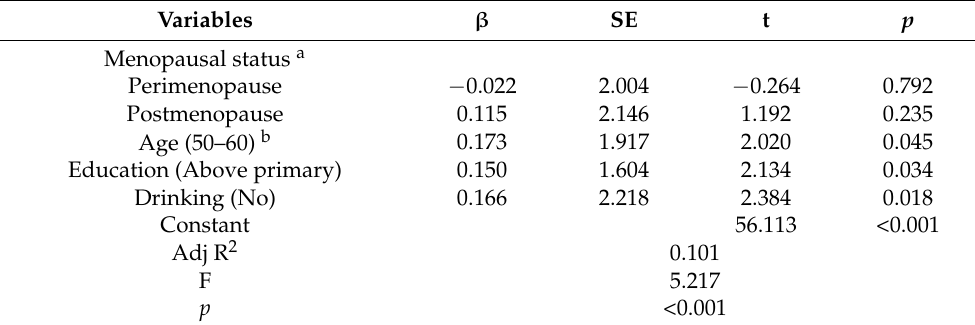
Table 4. Multiple regression analysis for factors altering the attitude towards